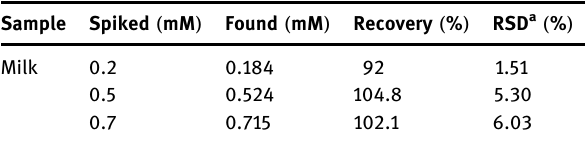
Table 2: Detection of hydrogen peroxide spiked in real milk